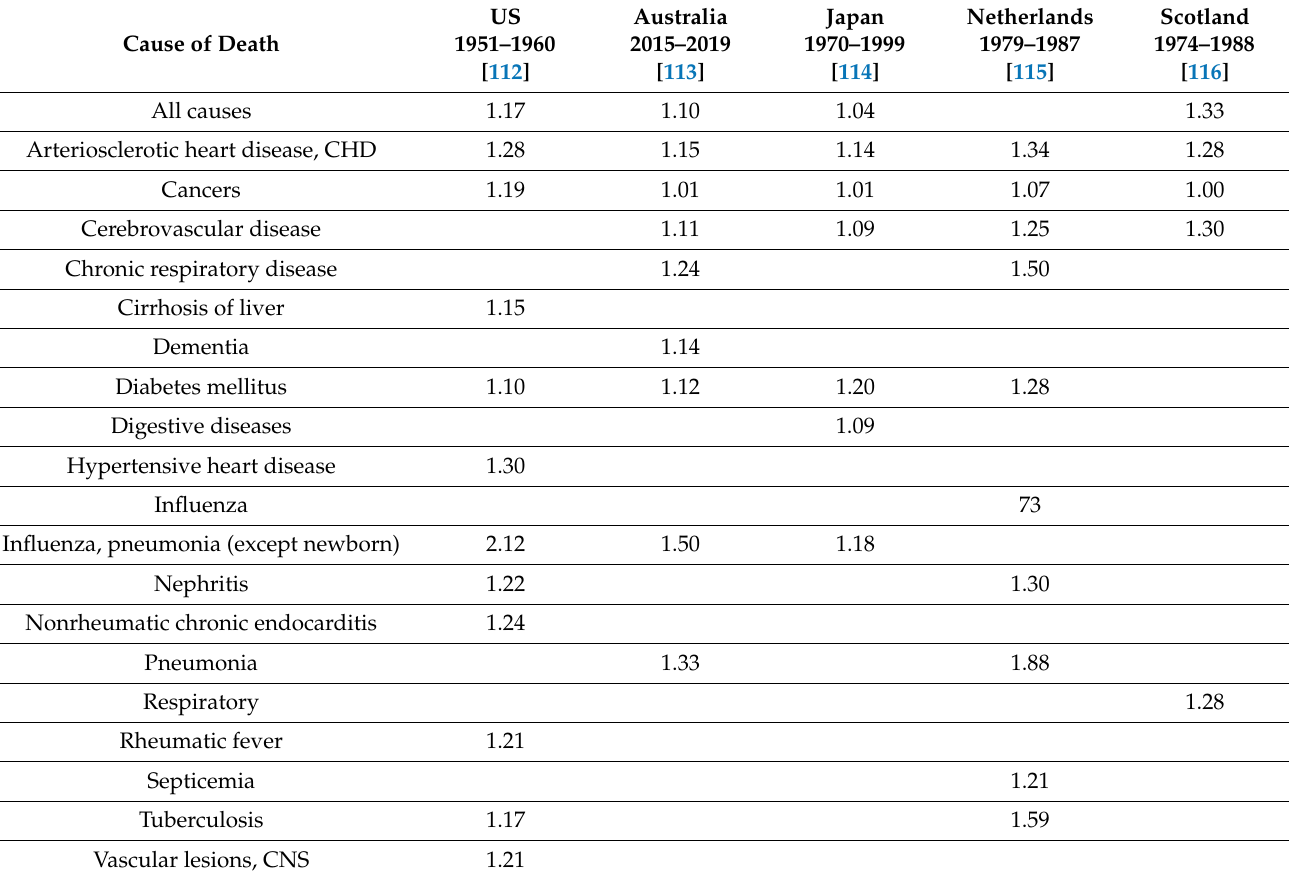
Table 1. Ratios of winter to summer mortality rate for common disorders in five